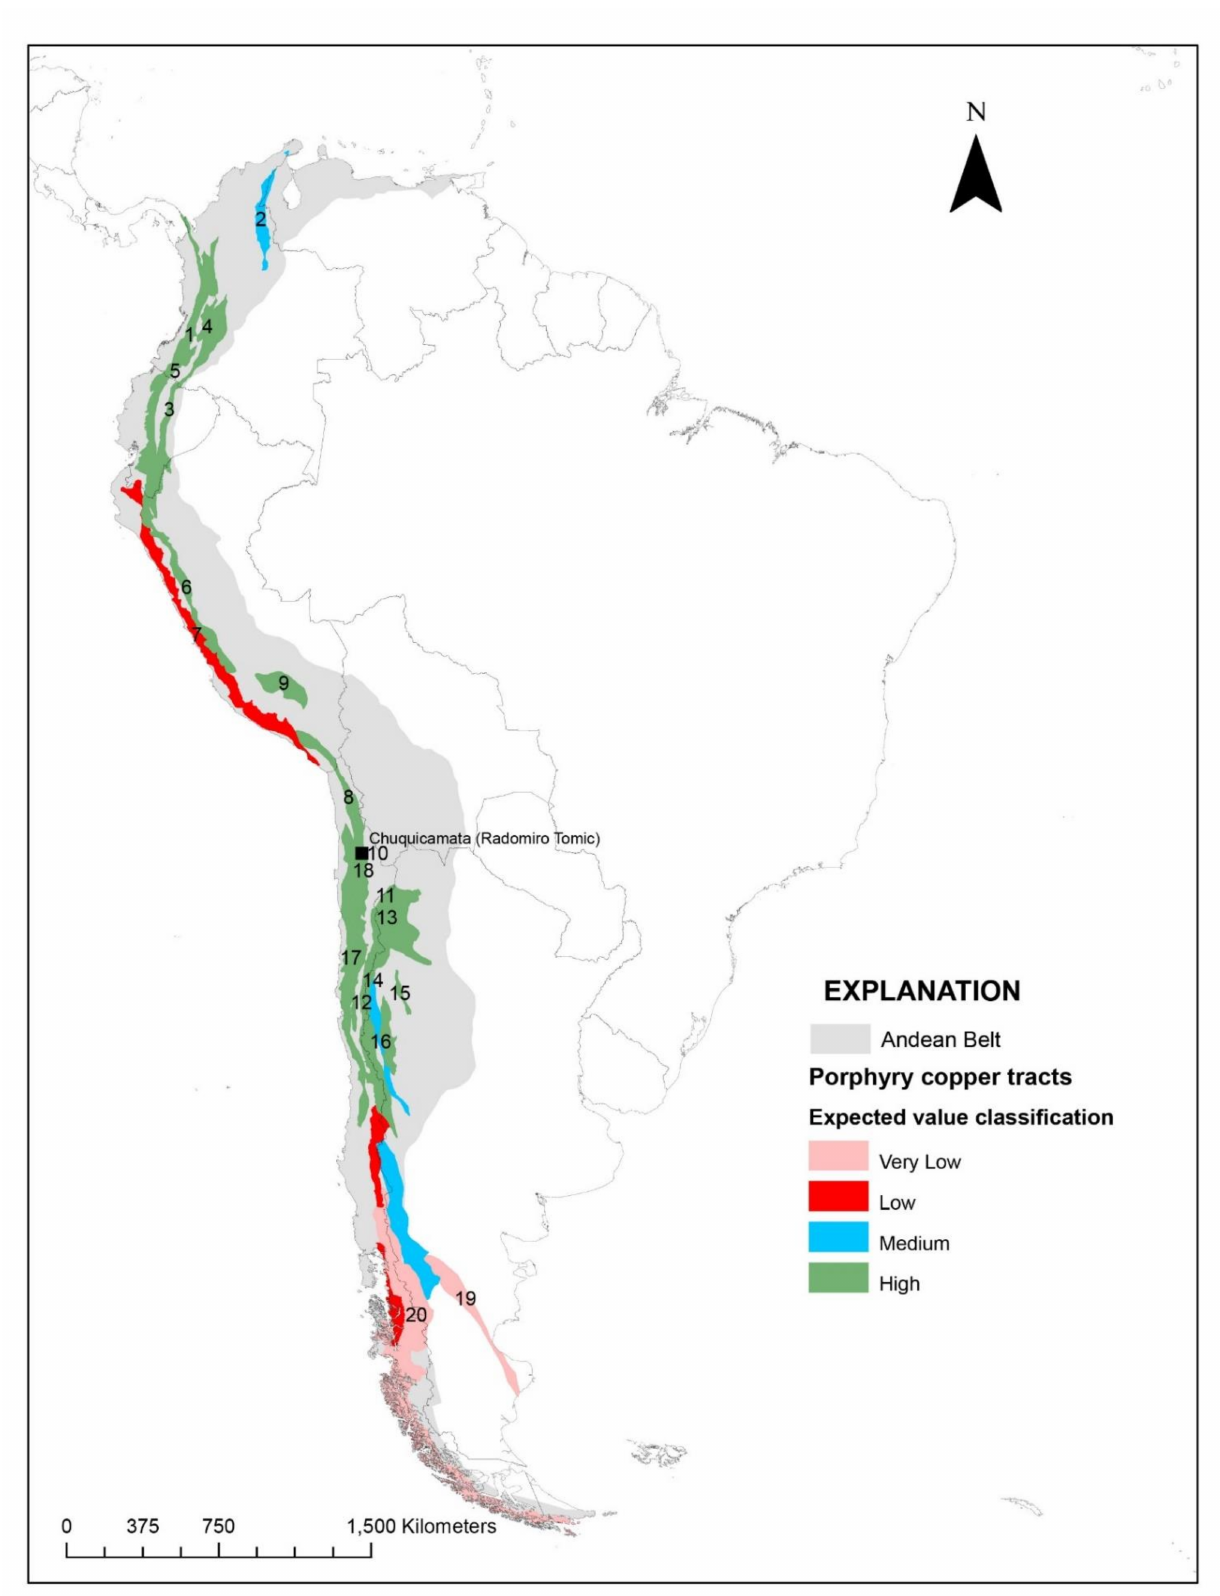
Figure 5. Map showing the distribution of permissive tracts for porphyry copper deposits by expected value classification. Tracts are from Cunningham et al. [8]; expected values are from Hammarstrom et al. [4]. See Table 1 for key to tract